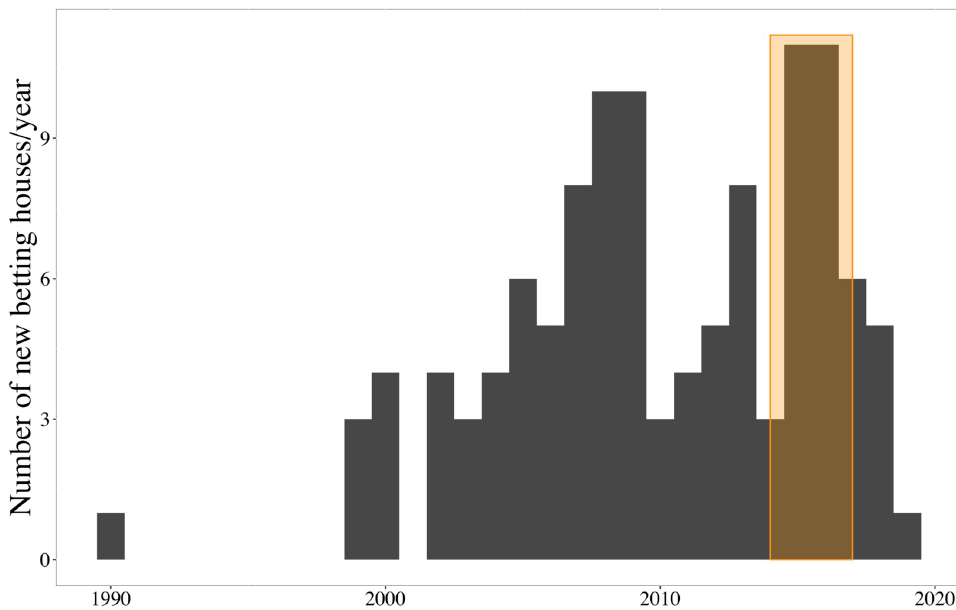
Fig 1. Betting houses openings. Opening year of ongoing betting houses in Madrid from 1990 to 2019. Note: Census data gathered from the Madrid City Council open data portal.